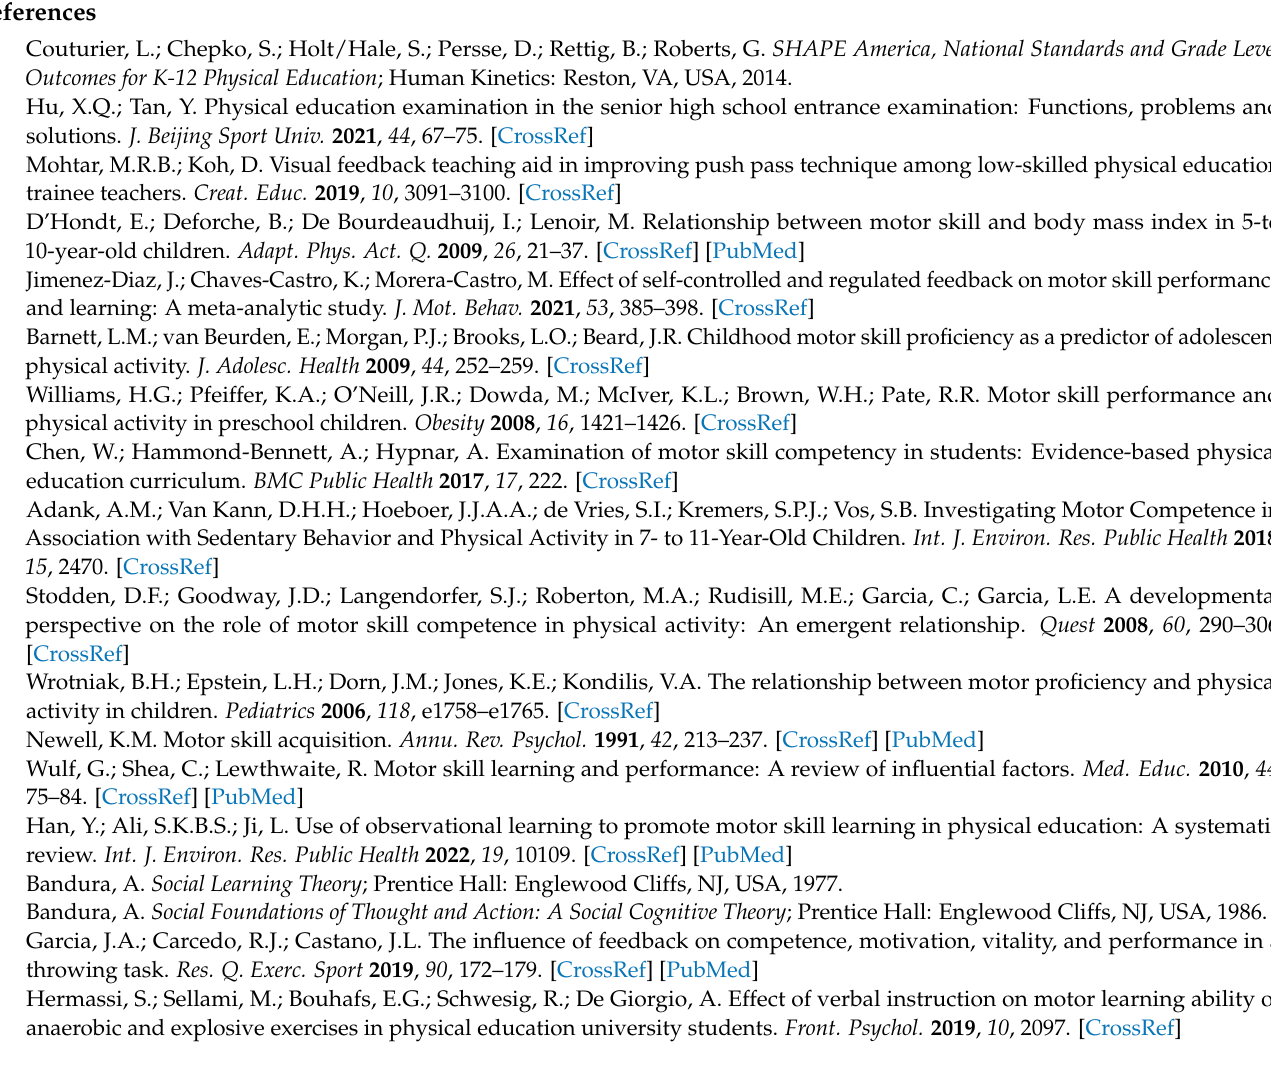
Table S1: Comparison with recent systematic reviews on the same